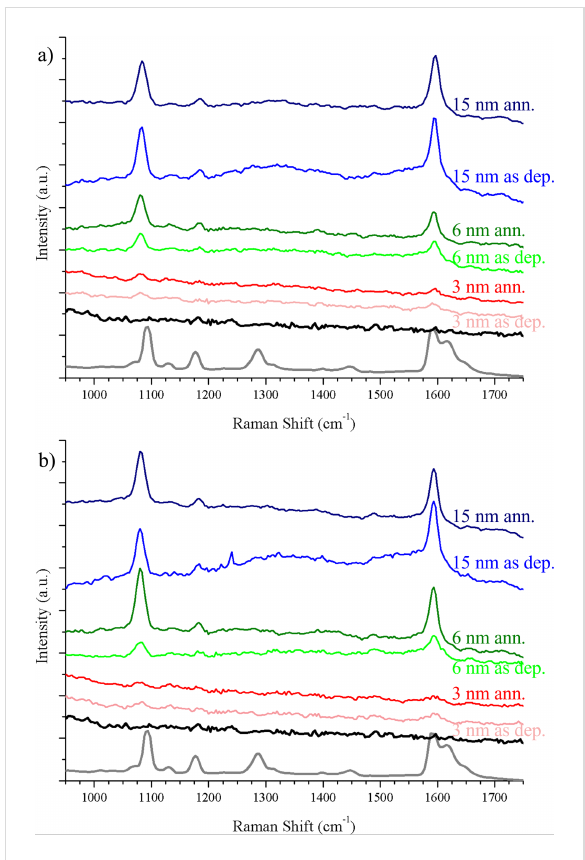
Figure 5: SERS measurements. The red, green and blue lines show SERS spectra of MBA deposited on, respectively, 3, 6, and 15 nm of Au deposited on TiO 2 surfaces at 8 Pa (a) and 12 Pa (b). The corre- sponding brighter color means that there was no annealing of the TiO 2 . Grey line: Raman spectrum of MBA powder (the intensity has been scaled down to be comparable with the SERS spectra). Black line: spectrum of MBA deposited on a TiO 2 surface without Au, yielding no SERS